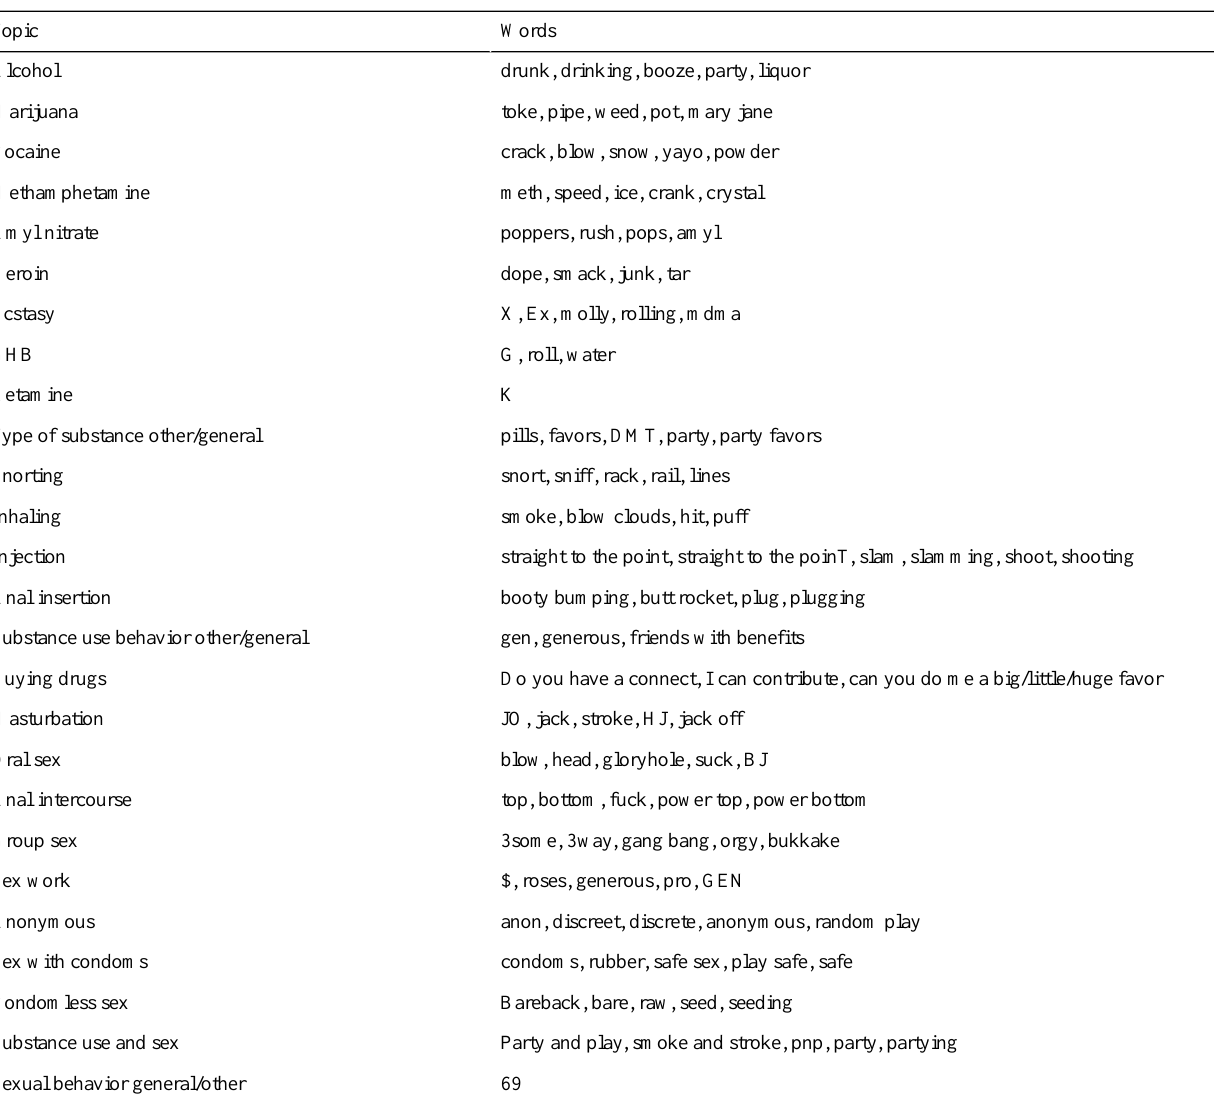
Table 1. Sexual and substance use topics associated with colloquial terms found in text conversations based on qualitative interviews with men who have sex with men community